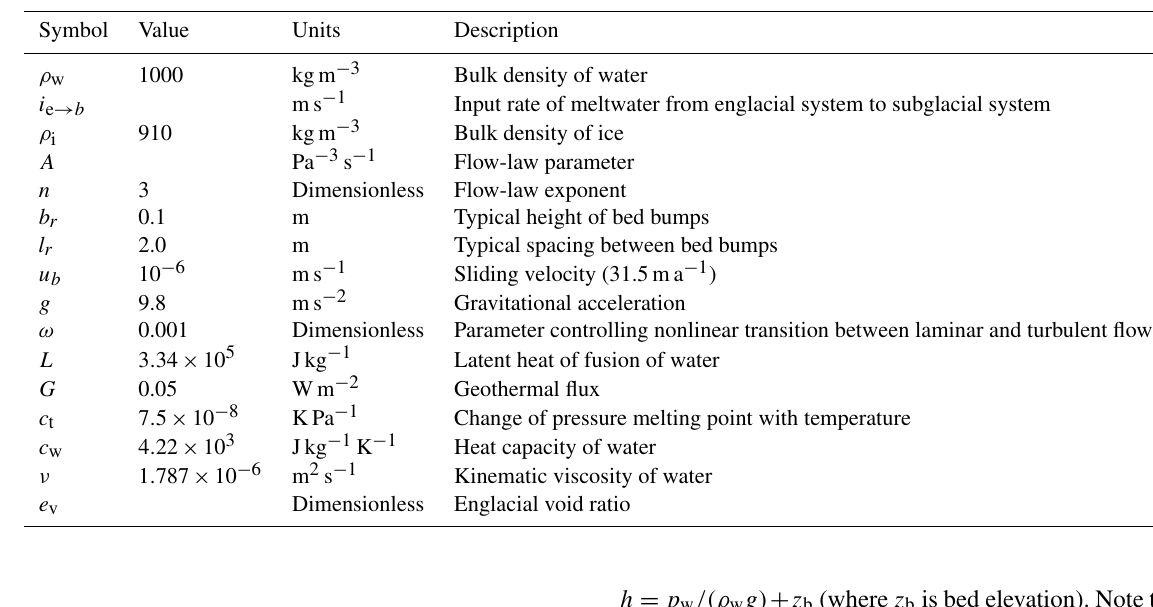
Table 2. Constants and